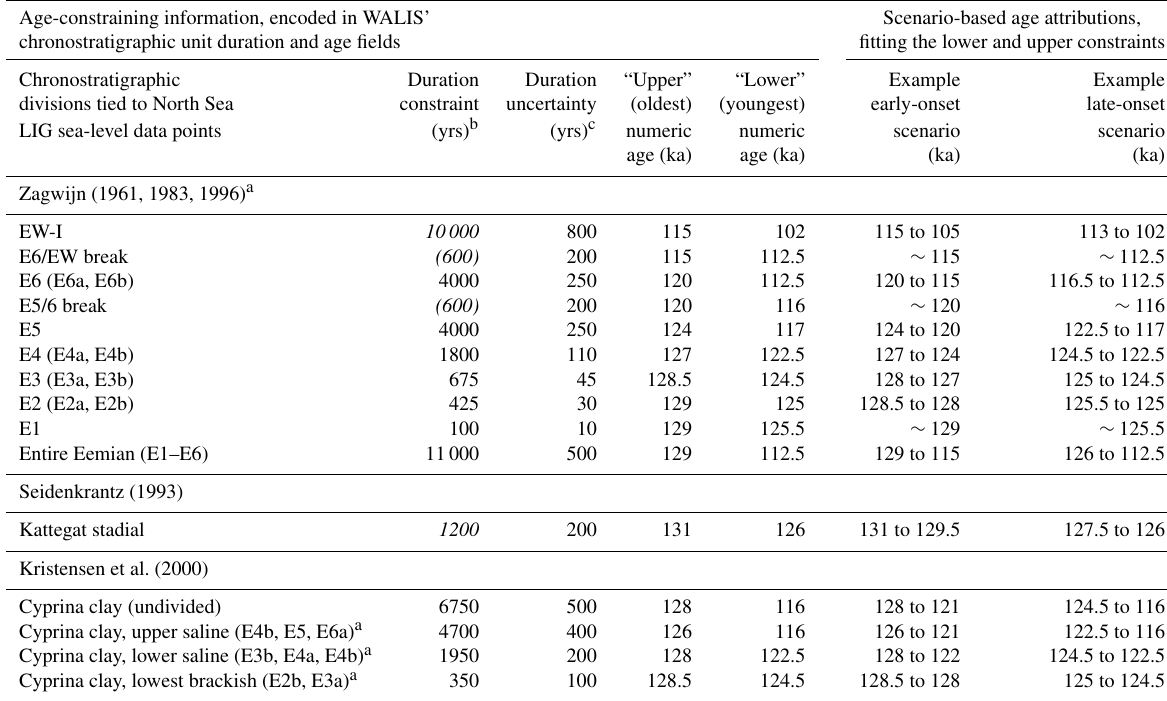
Table 4. Chronostratigraphical entries for North Sea, Skagerrak–Kattegat and SW Baltic Sea. Age-constraining information, encoded in